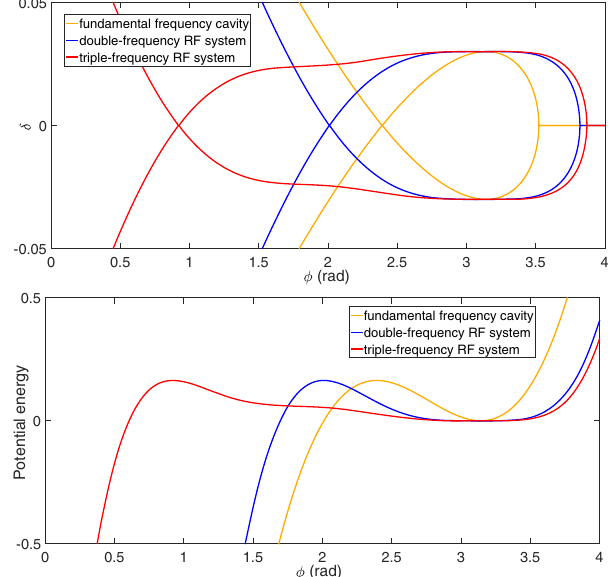
FIG. 5. Various longitudinal acceptances and potential energy curves under the different rf systems. Only the fundamental cavity, the double-frequency rf system and the triple-frequency rf system correspond to yellow, blue and red curves,